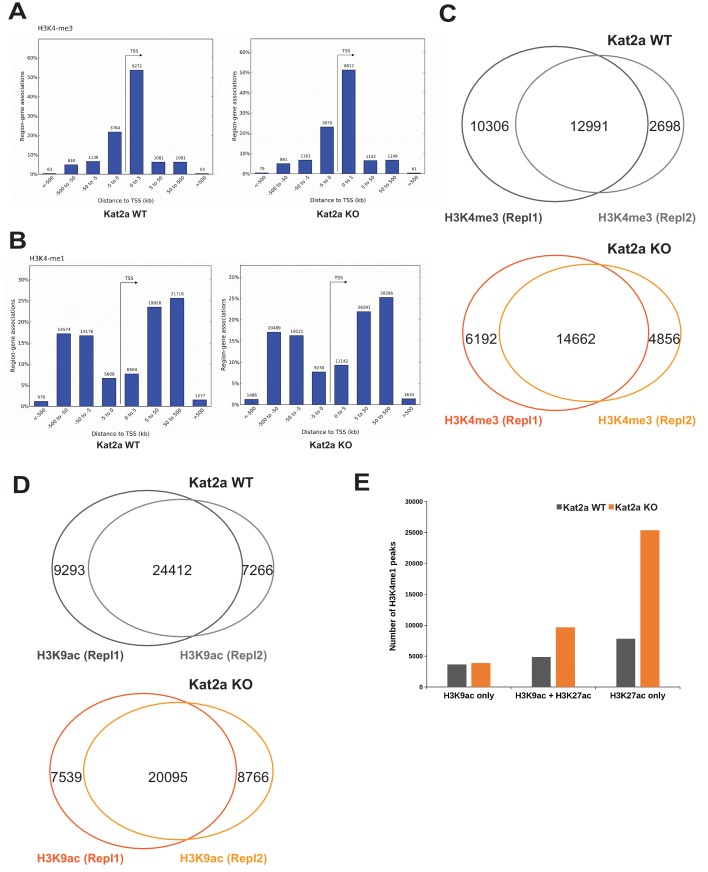
ChIP identification of regulatory regions in primary MLL-AF9 leukemia.(A) Localization of H3K4 tri-methyl (me3) peaks relative to the transcriptional start site (TSS) in Kat2a WT and Kat2a KO primary MLL-AF9 leukemias. (B) Localization of H3K4 mono-methyl (me1) peaks relative to the transcriptional start site (TSS) in Kat2a WT and Kat2a KO primary MLL-AF9 leukemias. (C–D) Venn diagrams representing peak overlap between (C) H3K4me3 and (D) H3K9ac duplicate ChIP-seq experiments. (E) Distribution of H3K9 and H3K27 acetylation (ac) marks in H3K4me1 (enhancer) peaks in Kat2a WT and KO primary MLL-AF9 leukemias.